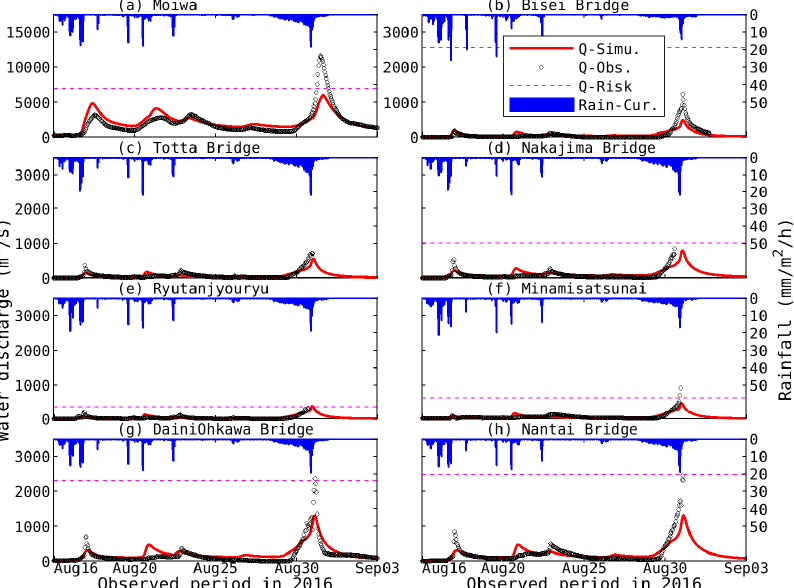
Figure 6. Discharge comparison of the linear bias-correction. All other information is identical to that in Figure